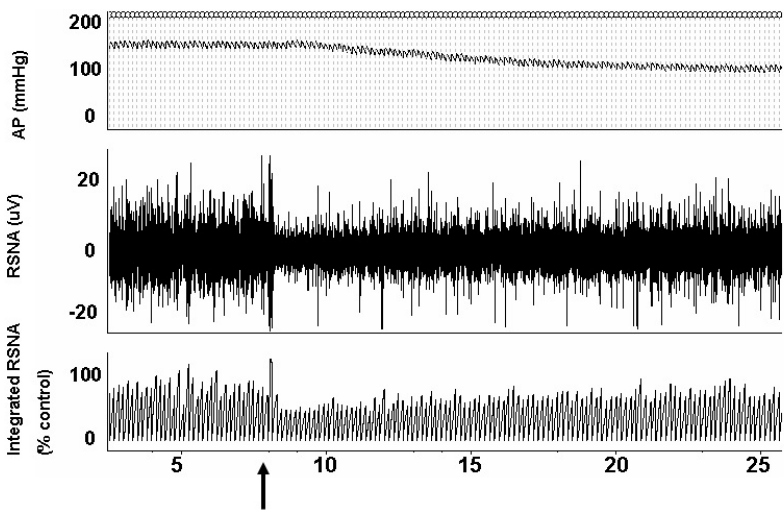
Fig. 2 – Segments of original recording demonstrating arterial pressure (AP), renal sym- patheticnerveactivity(RSNA)andintegratedRSNAresponsestobilateralmicroinjection of kynurenic acid (4 nmol/100 nl, bilaterally) into the RVLM (arrow) in a renovascular hypertensive rat (Goldblatt model, 2 kidneys-1clip). Time in seconds. (Modified from Bergamaschi et al.